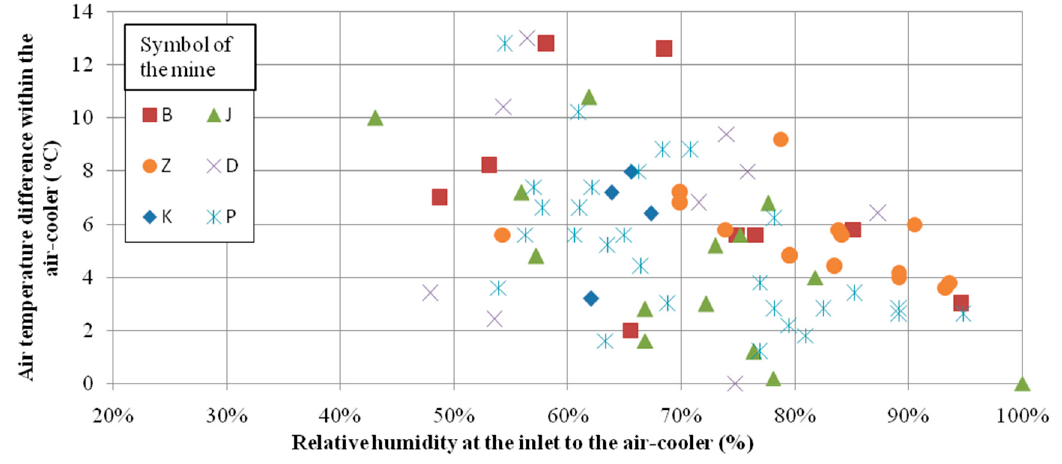
Figure 12. The influence of humidity on lowering the temperature by spot air-coolers in particular mines.